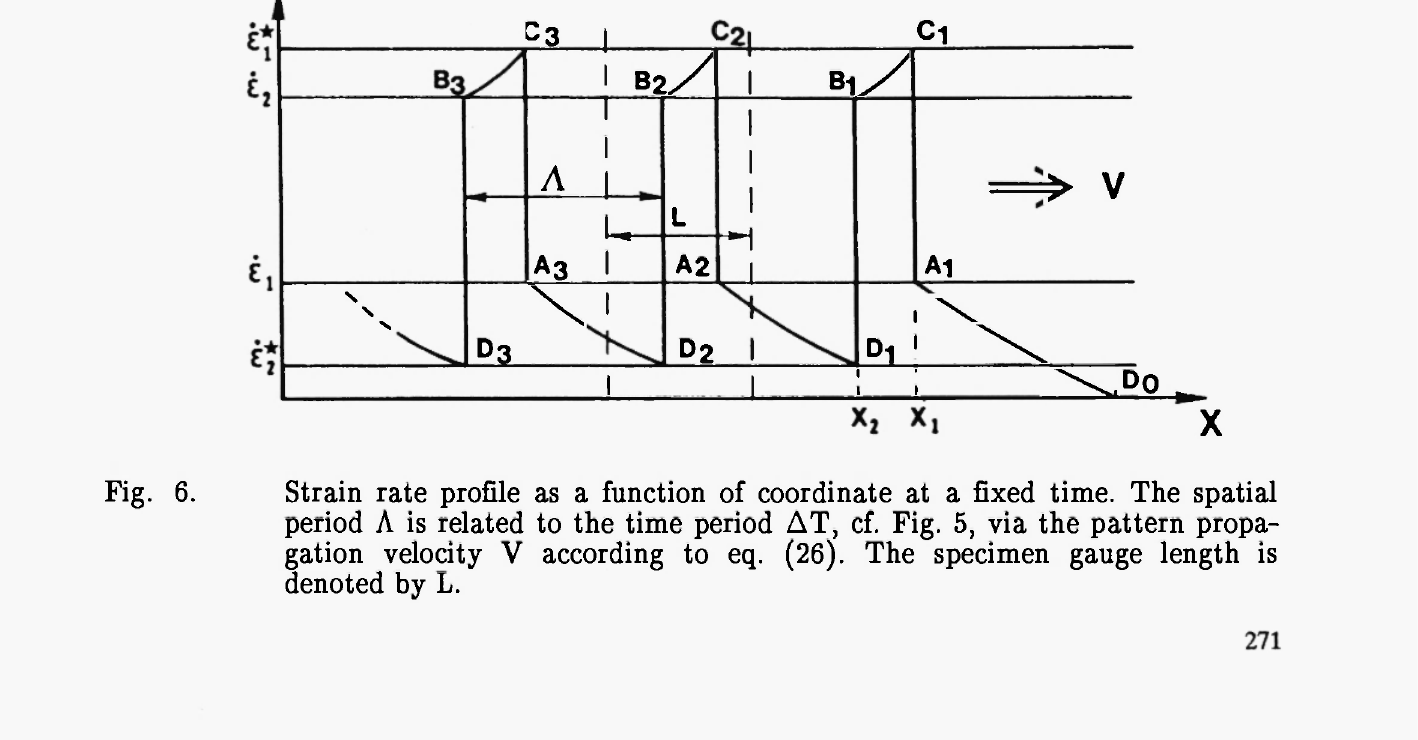
Fig. 6. Strain rate profile as a function of coordinate at a fixed time. The spatial period Λ is related to the time period Δ Τ, cf. Fig. 5, via the pattern propa- gation velocity V according to eq. (26). The specimen gauge length is denoted by